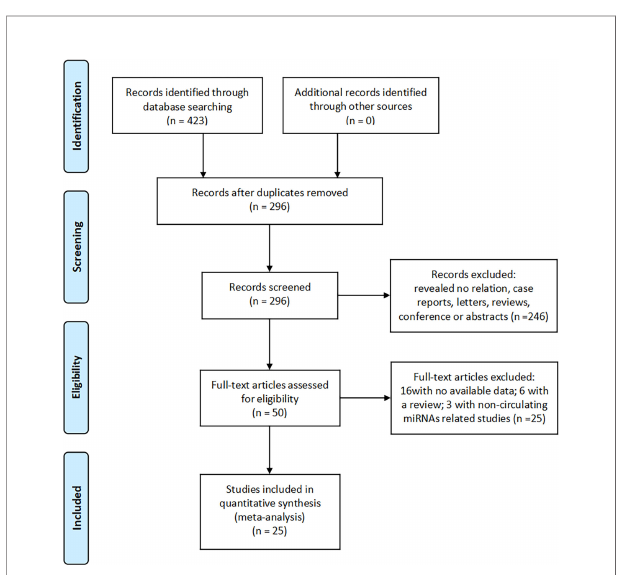
FIGURE 1 | Flow diagram showing selection of studies for